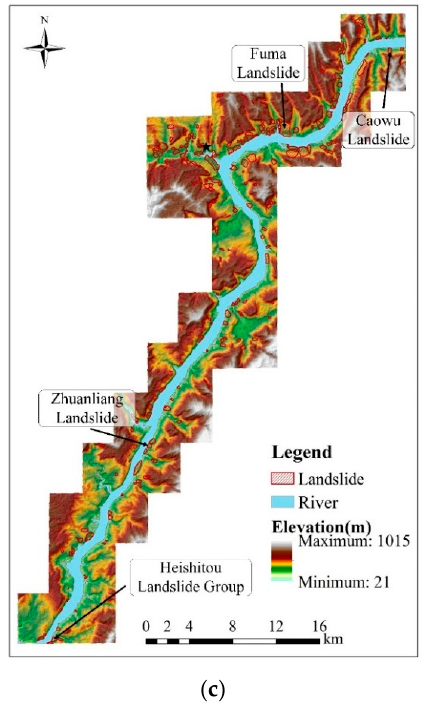
Figure 7. Location map of the study area. ( a ) Site map of the Three Gorges Reservoir; ( b ) site map of our study area; ( c ) digital elevation mode (DEM) overlaid with previously investigated landslides. The red hatched regions represent previously investigated landslides in the study area.